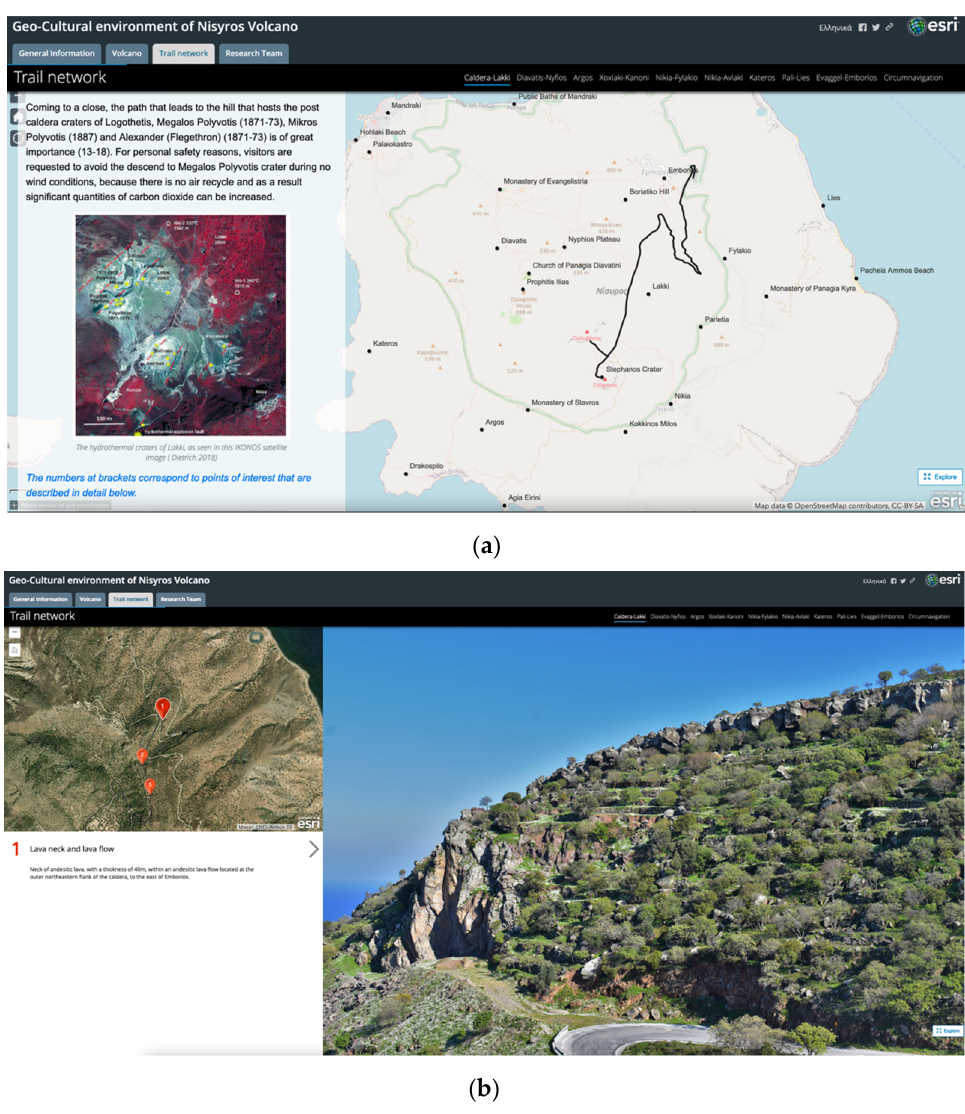
Figure 16 . Screenshots showing the two ways of presenting each trail, general information ( a ) and information for each point of interest ( b ).